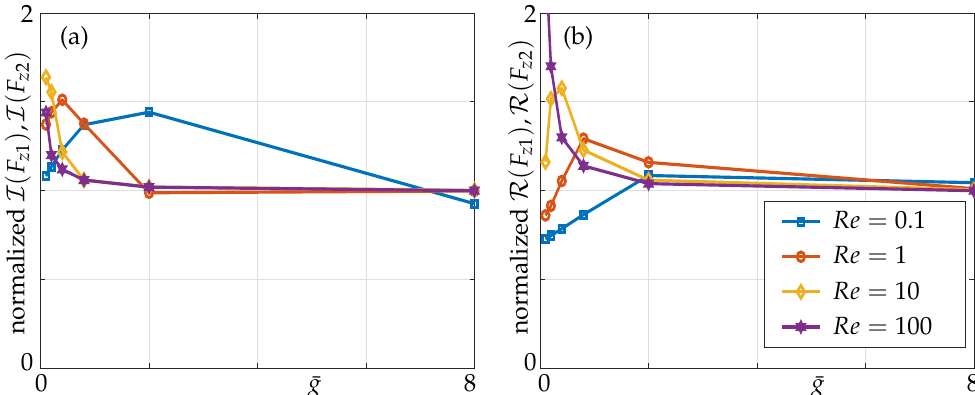
Figure 6. Hydrodynamic load of 2 beams for different gap sizes ¯ g subject to a 1–1 actuation mode; ( a ) imaginary parts of forces, ( b ) real parts of forces; note that lines of beams 1 and 2 perfectly align with the solid lines representing Basak’s results and marks our validation against